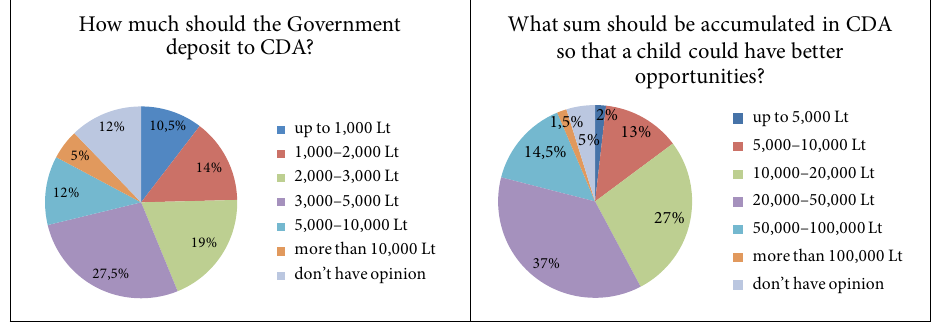
How much should the Government deposit to